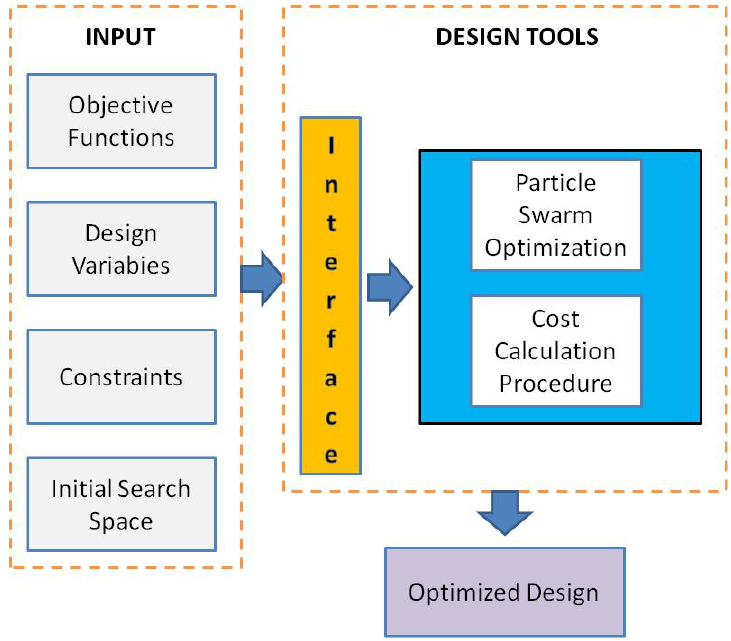
Figure 4. The flowchart of the developed computer program.